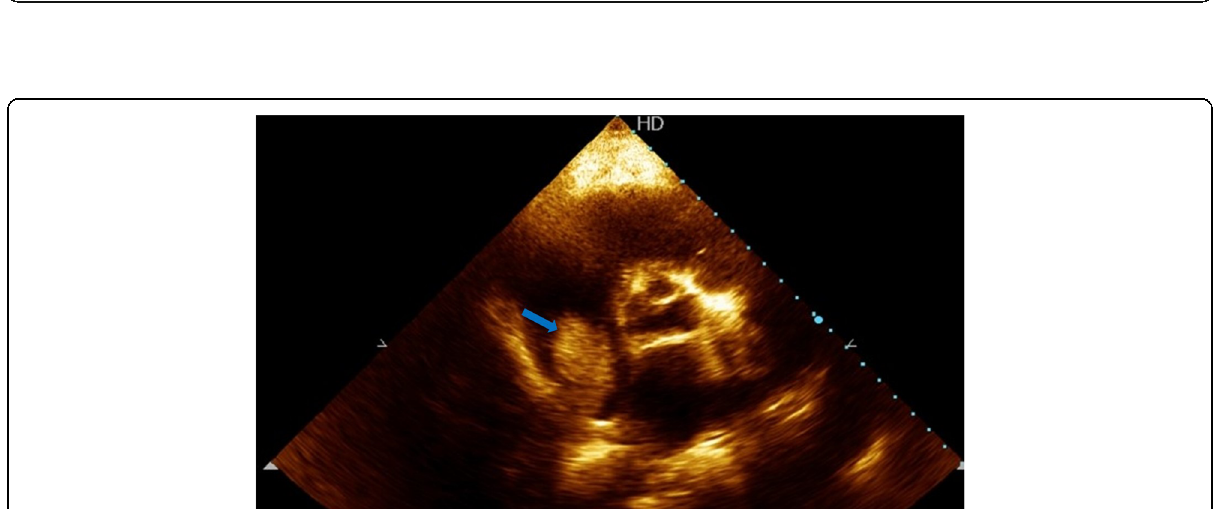
Fig. 2 TTE showing a large right atrial mass measuring 4.5 × 2.5 cm marked by a blue arrow